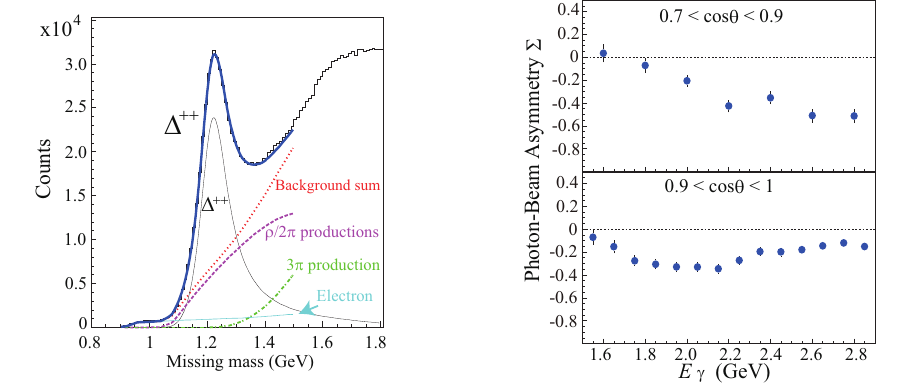
Figure 2. (Left) Missing mass of the p ( γ,π − ) X reaction for E γ = 1 . 5 − 2 . 95 GeV. (Right) Photon beam asymmetries ( Σ ) for the γ p → π − Δ ++ reaction in two di ff erent angle